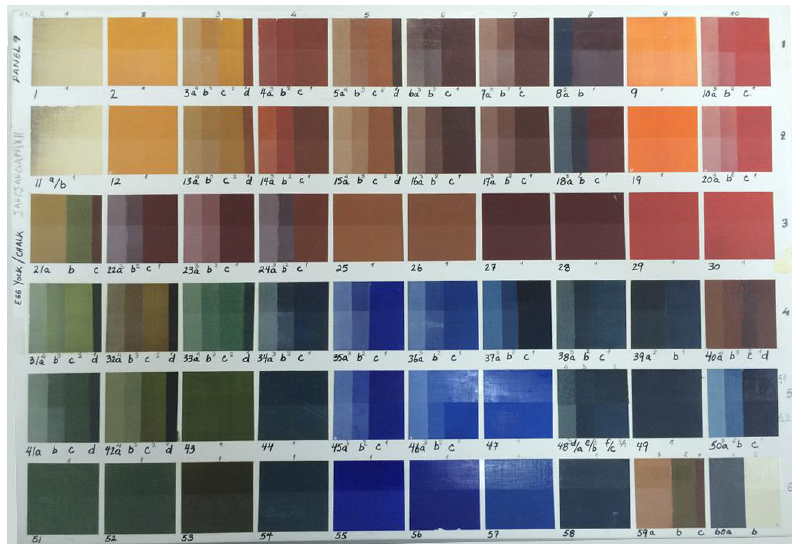
Figure 1. The multi-material palette of fundamental pigments of Byzantine iconography. A protective varnish is applied on the upper region of each